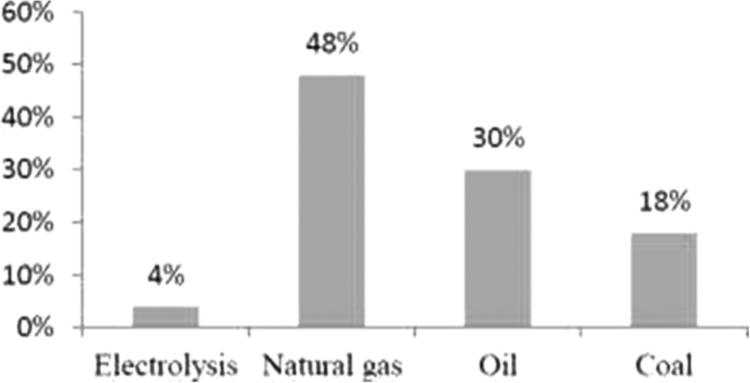
Origin of hydrogen currently produced worldwide [9].